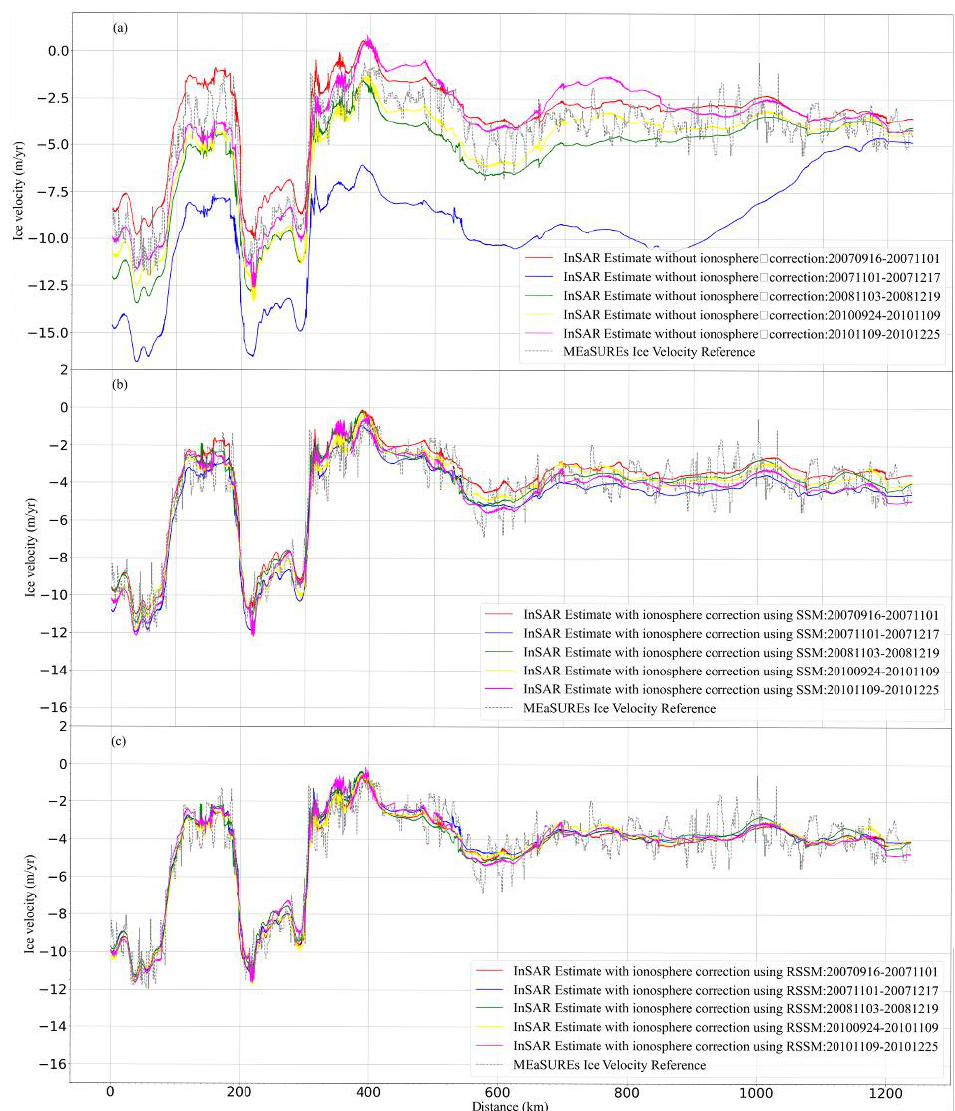
Figure 9. The time-series ice-velocity measurements profile analysis without ionospheric correction and with ionospheric correction using SSM and RSSM in Antarctica. ( a – c ): Reference ice velocity from MEaSUREs (gray) and InSAR-derived ice velocity measurements without ionospheric correction and with ionospheric correction using SSM and RSSM (other colors).